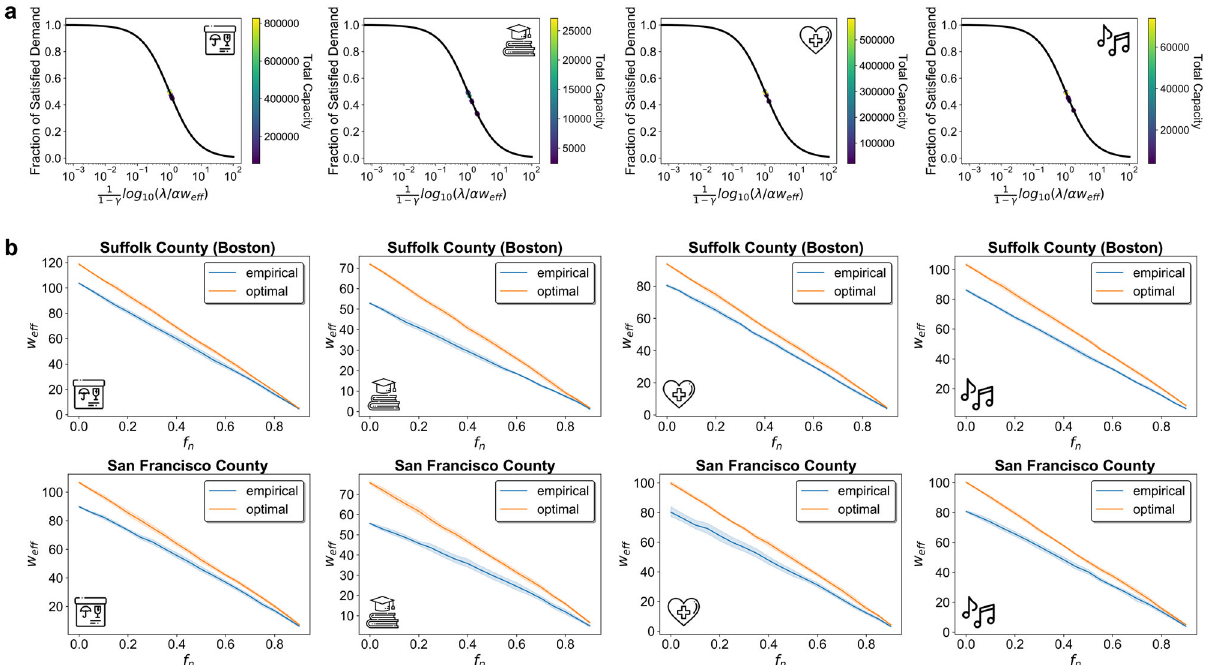
Fig. 5 The quanti fi cation of resilience improvement in both empirical and optimal scenarios. a The equilibrium solutions for the resilience model based on existing resolutions. ( γ = 0.5, and λ = 0.0464 in these cases). b The relationship between effective distance and removed proportion of facilities to quantitatively describe the resilience of the PF network. The change of the effective distance, w eff , due to the change of facility distributions in optimal and existing distributions. When a proportion of facilities ( f n ) are randomly removed from the counties, the effective distance also changes. The results for four example types of facilities for two counties, Suffolk and San Francisco counties, are displayed here. More results are provided in Supplementary Figs. 12,